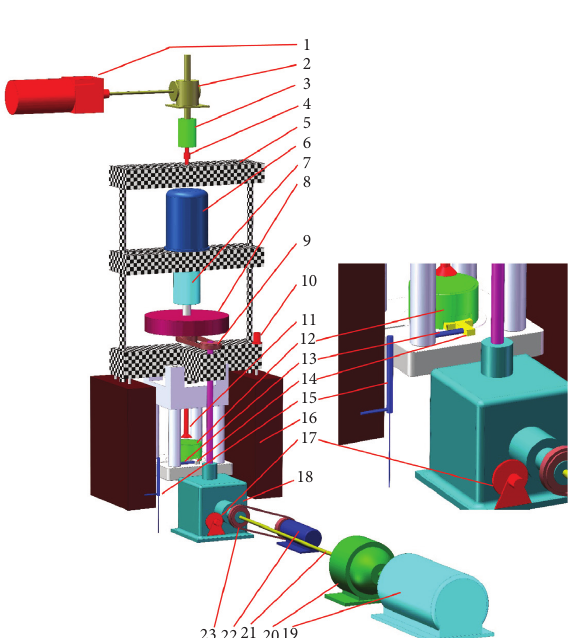
Figure 2: Experimental apparatus for stick slip mitigation by axial impact. 1 Servo motor; 2 Lifter; 3 Disc spring; 4 Tension sensor; 5 Lifting framework (parts marked with black-and-white grids as a whole are referred to as the lifting framework); 6 Impactor motor; 7 Impactor; 8 Spindle; 9 Rotational inertia wheel; 10 Chain mechanism; 11 Base (the grey white mechanism as a whole is referred to as the base); 12 Link mechanism; 13 Bit; 14 Core sample holder; 15 Pendulum rod; 16 Torque sensor; 17 Balancing weight; 18 Commutator; 19 Angular velocity sensor; 20 Drill string drive motor; 21 Reducer; 22 Torsion rod spring; 23 Permanent magnetic DC motor; 24 Chain